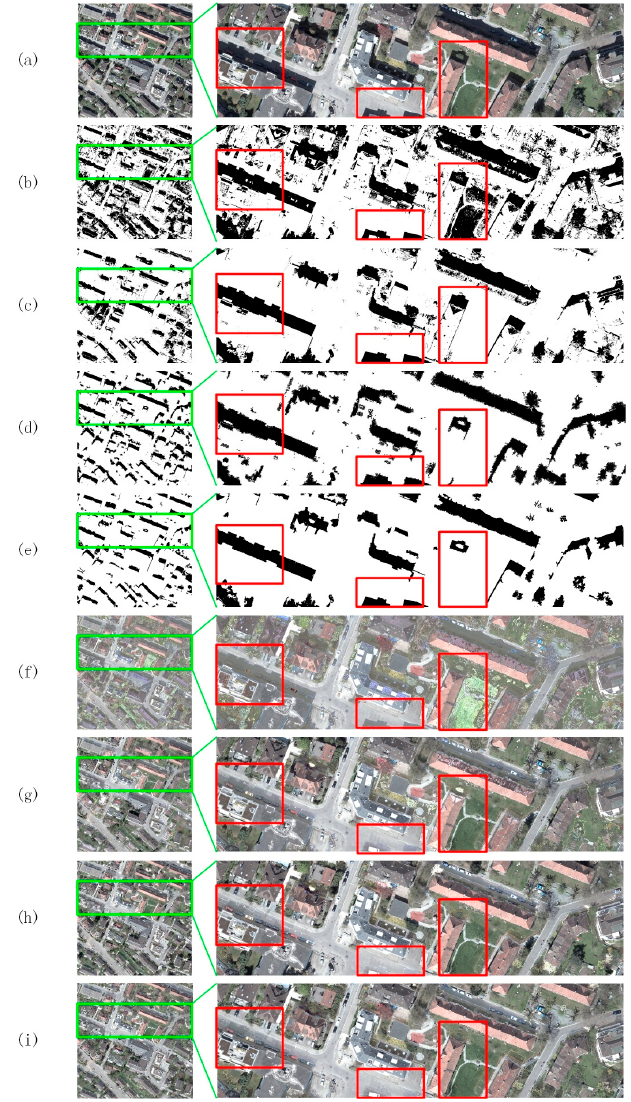
Figure 8. Results of the shadow detection and removal methods in test 3, and zoomed images of the green boxes: ( a ) original imagery; ( b ) result of TSM; ( c ) result of LMM; ( d ) result of the proposed method; ( e ) manually delineated shadow mask; and ( f – i ) shadow compensation results based on the shadow masks in ( b – e ).